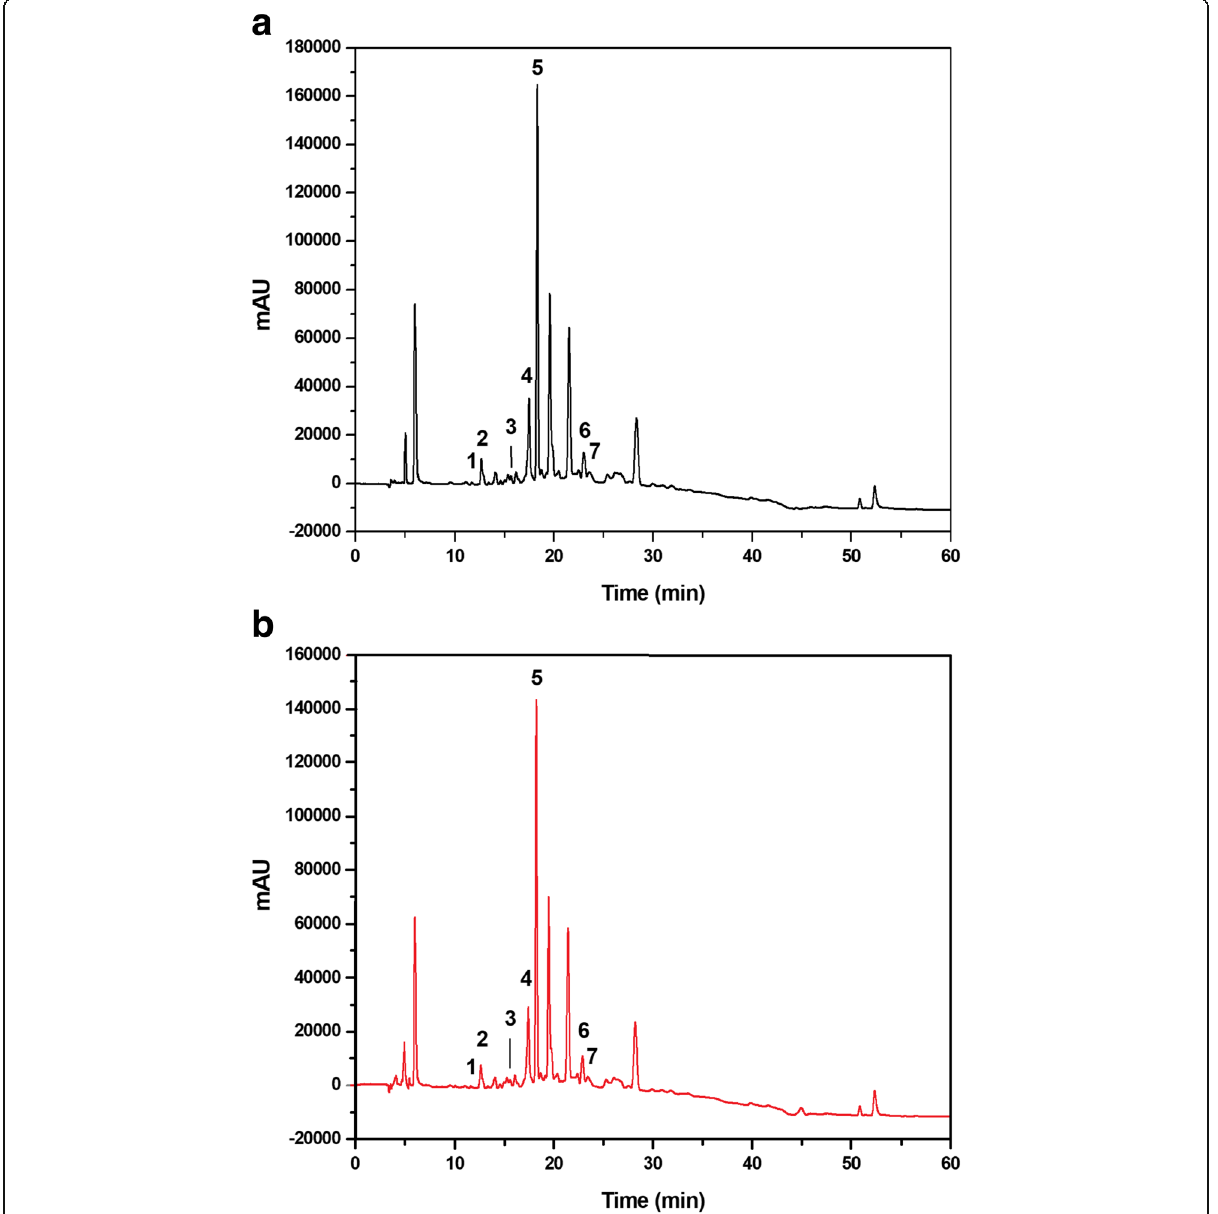
Fig. 1 Markers of Brazilian red propolis extract using UPLC-DAD. Chromatograms of an ethyl acetate extract of Brazilian red propolis ( a , black line) and 1% micellar nanocomposite loaded with EARP ( b , red line) at a concentration of 500 μ g/mL. Identification of daidzein (1), liquiritigenin (2), pinobanskin (3), isoliquiritigenin (4), formononetin (5), pinocembrin (6), and biochanin A (7) flavonoids in the UPLC-DAD profile at a wavelength of 205